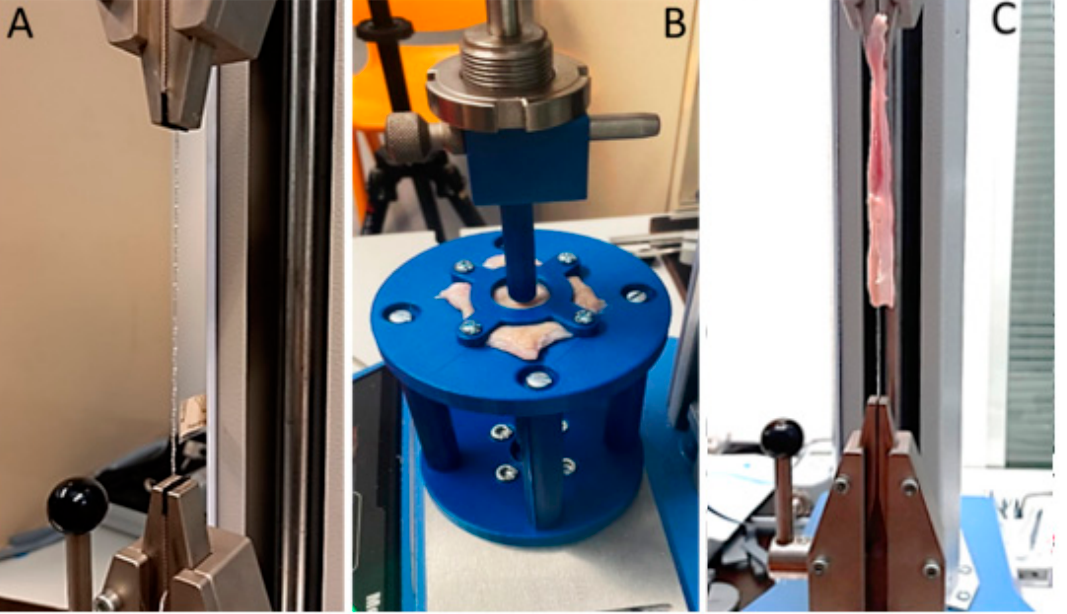
Figure 1. ( A ) Cog thread uniaxial tensile testing; ( B ) Vaginal wall-cog thread ball burst testing; ( C ) Vaginal wall strips—cog thread pulling test.